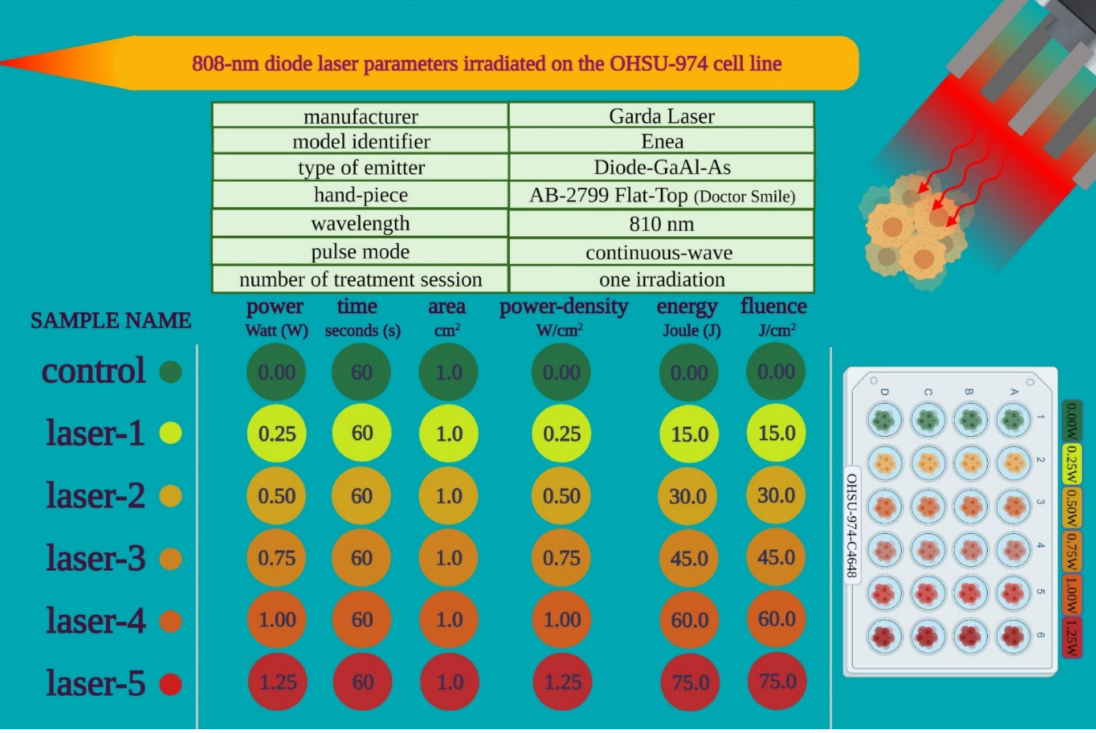
Figure 1. Outline of the PBM treatment parameters used in the study. The cancer cell line from human tongue squamous cell carcinoma (Figure 2A) was transferred into a black 24 well plate with a flat and clear bottom (Figure 2B). Treatments were performed with the flat-top hand-piece in contact with the well top, which corre- sponds to a distance of 1.86 cm from the cells (Figure 2C), as stated by the manufacturer (IBIDI GmbH, 82152 Martinriesd, Munich, Germany). PBM therapy was